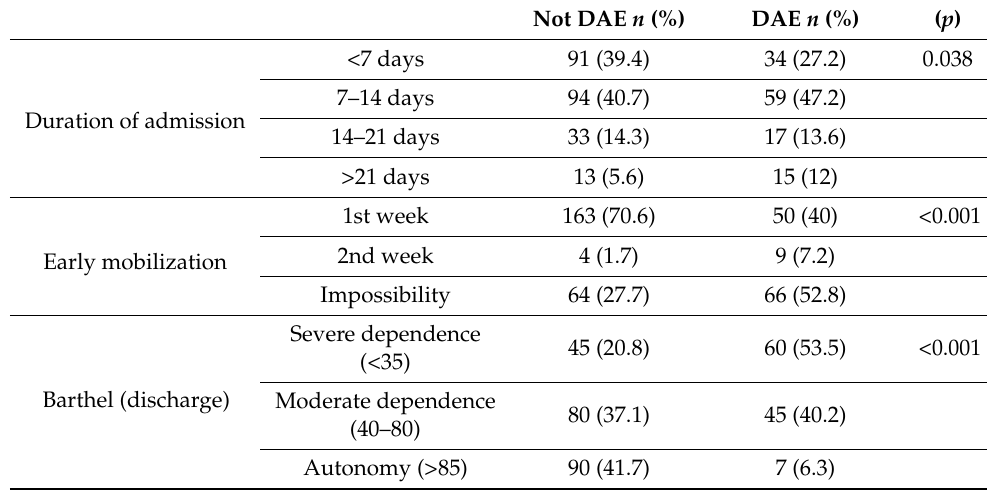
Table 5. The evolution of hospital admission until